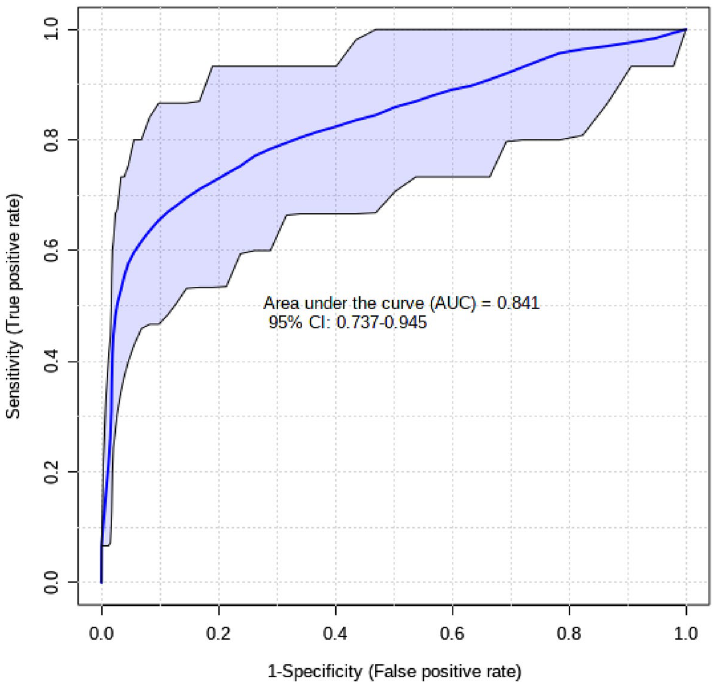
Figure 2. Receiver operating characteristics (ROC) curve of biomarkers of pregnant ewes with a single or more than two lambs. The comparison of SNG vs TRP groups identified methionine and l-carnitine as significant (p-value < 0.001) biomarkers that would identify ewes that carry a single lamb or those that carry more than two